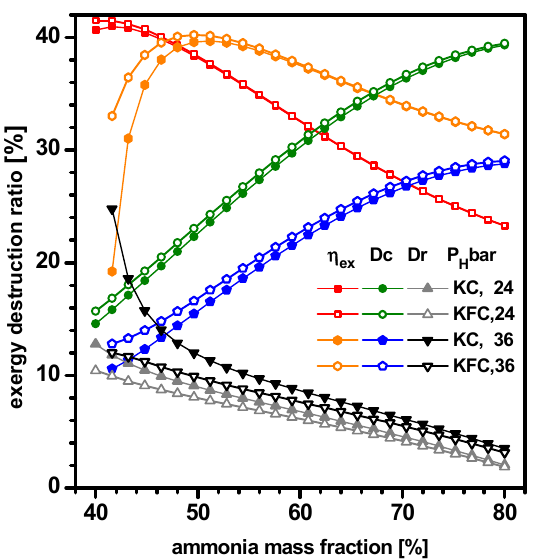
Figure 7. Dependence of η ex , Dc , and Dr on ammonia mass fraction for P H = 24, 36 bar in the KC and KFC.